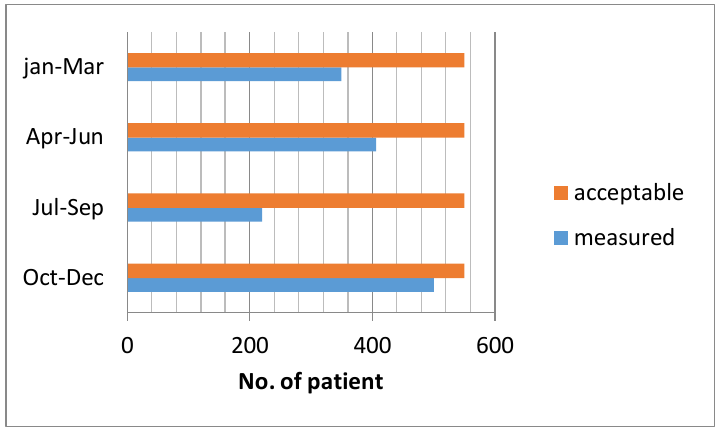
Fig. 7. The number of emergency surgery in year 2011.